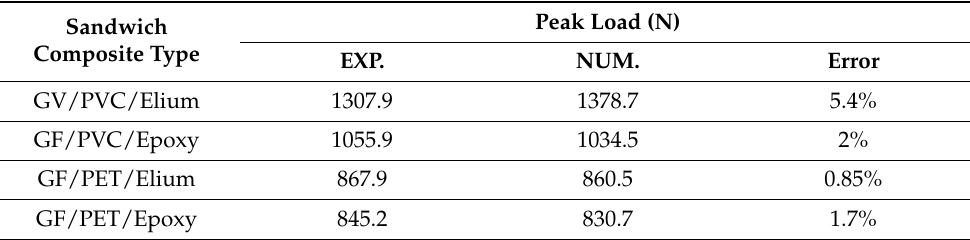
Table 6. The experimental and numerical results of GFRP sandwich composites’ peak load (N) under flexural loading.